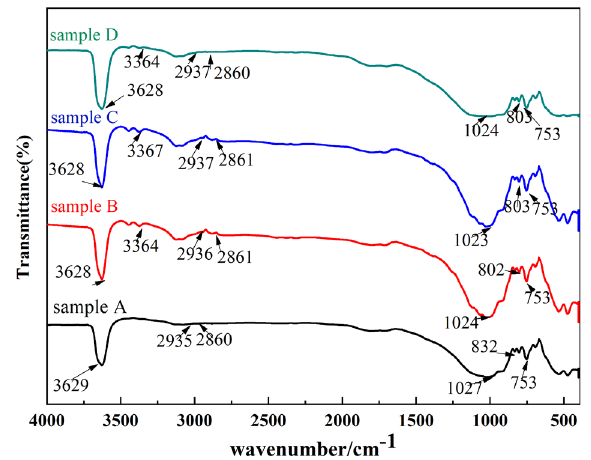
Figure 9. Infrared spectra of different muscovite samples (pH=12, c(Sodium oleate)=9.20 × 10 −4 mol/L, c(Cu 2+ )=6 × 10 −5 mol/L).